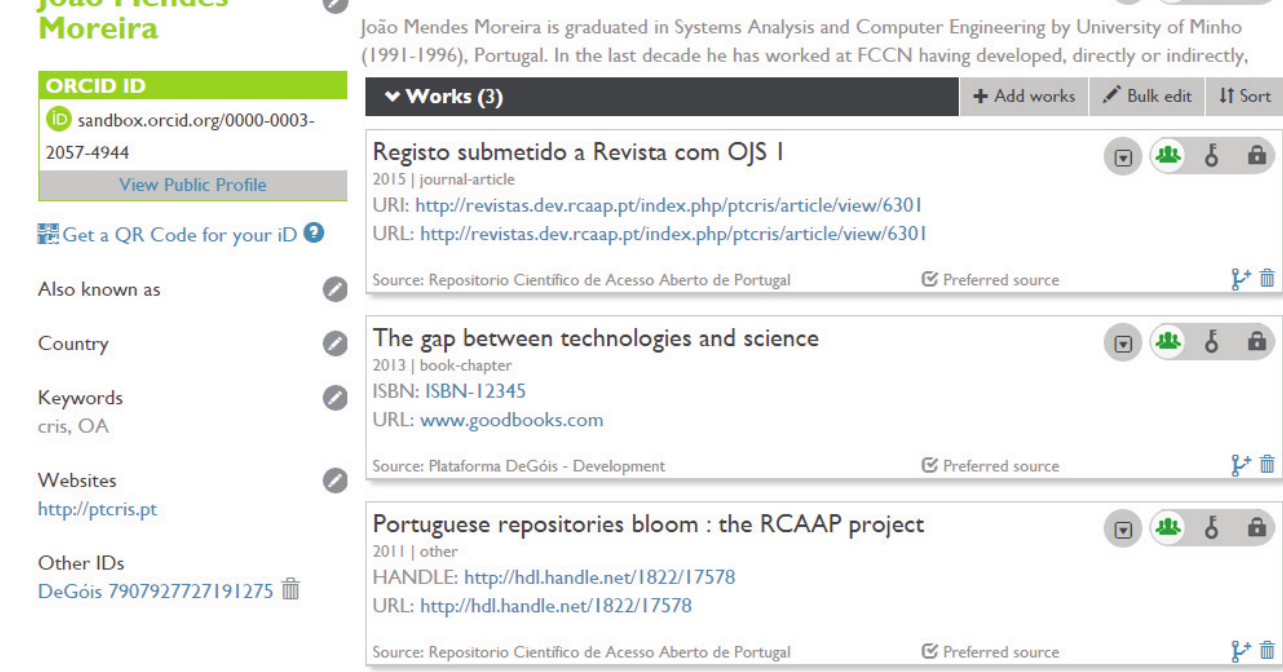
Figure 9. User profile at